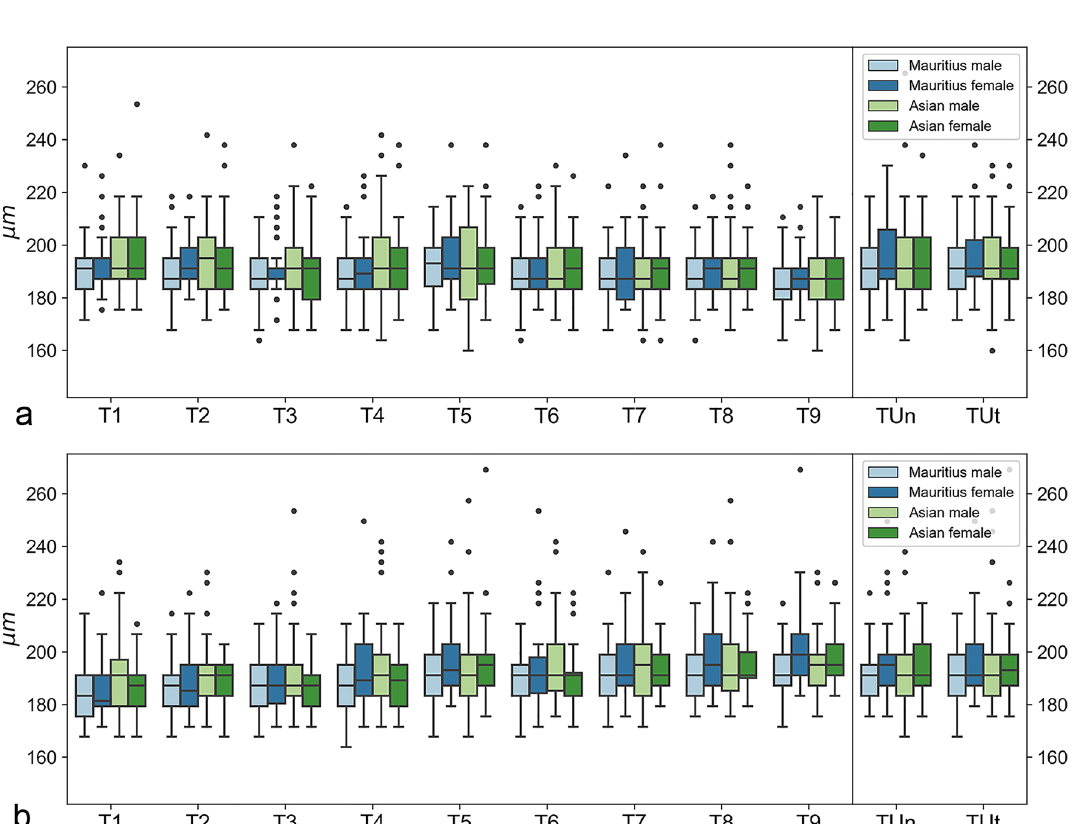
Figure 3. Boxplots of sex-specific and origin-specific variations in choroidal thickness for right ( a ) and left ( b ) eyes. Numerical data of Mauritius male, Mauritius female, Asian male, and Asian female are plotted for each thickness coefficient. Rectangular boxes represent interquartile ranges (IQR), which extend from Q1 to Q3. Black lines in the middle of IQR indicate medians. Upper whiskers extend to the last datum, which is smaller than Q3 + 1.5 × IQR. Lower whiskers extend to the first datum, which is greater than Q1 − 1.5 × IQR. Data beyond whiskers are outliers and plotted as black